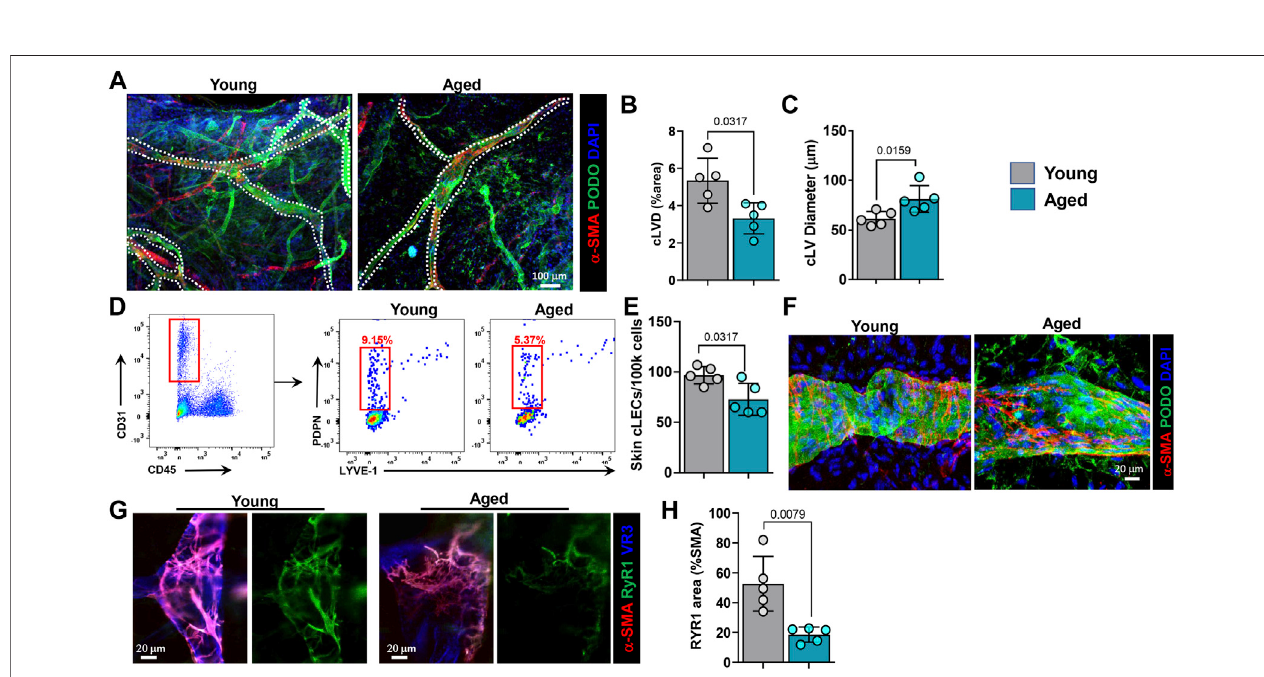
FIGURE 2 | Aging causes decreases in collecting lymphatic vessel density and collecting LEC numbers and alters their phenotype. (A) Representative confocal imagesofmouseskincollectinglymphaticvesselsshowingcolocalizationofPDPNand α -SMA.Quanti fi cationofcollectinglymphaticvessel (B) densityand (C) diameter. (D) Representative fl ow cytometry dot plots showing frequencies of CD31+/CD45-/PDPN+/LYVE-1- collecting LECs. (E) Quanti fi cation of the absolute number of skin collecting vessel LECs among 100,000 total cells. (F) Representative high magni fi cation confocal images of young and aged collecting lymphatic vessels showing orientation of LMCs ( α -SMA) relative to LECs (PDPN). (G) Representative high magni fi cation confocal images of young and aged collecting lymphatic vessels showing expressionofryanodinereceptor1(RyR1)inLMCs( α -SMA). (H) Quanti fi cationofRyR1densityasapercentageofLMCdensity. n =5micepergroupforallexperiments. All quanti fi cations are mean ± SD, unpaired Student ’ s t test.